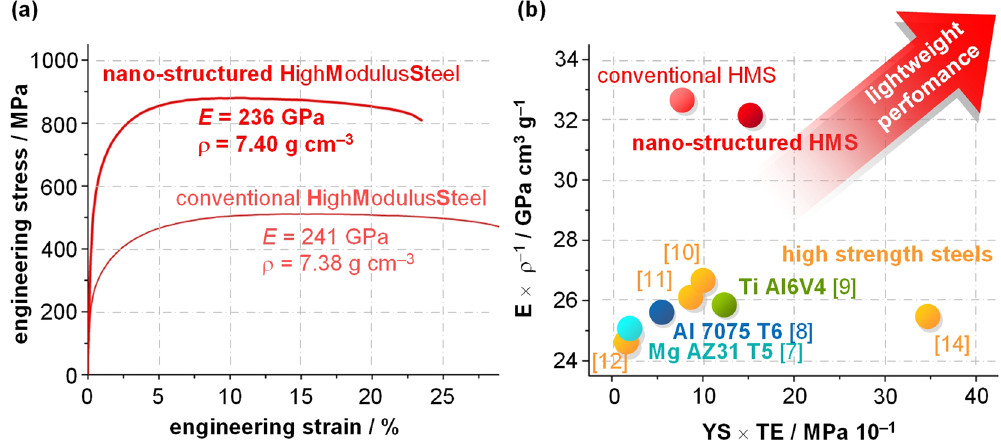
Figure 5. ( a ) Tensile testing results and physical properties of conventional and novel nano-structured High Modulus Steels. ( b ) Materials property map of all key factors for lightweight design showing the unique property profile of nano-structured High Modulus